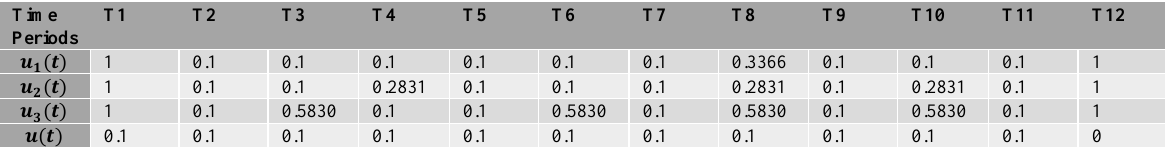
Table 4. Optimal value of segment specific and single channel advertising effort rate.